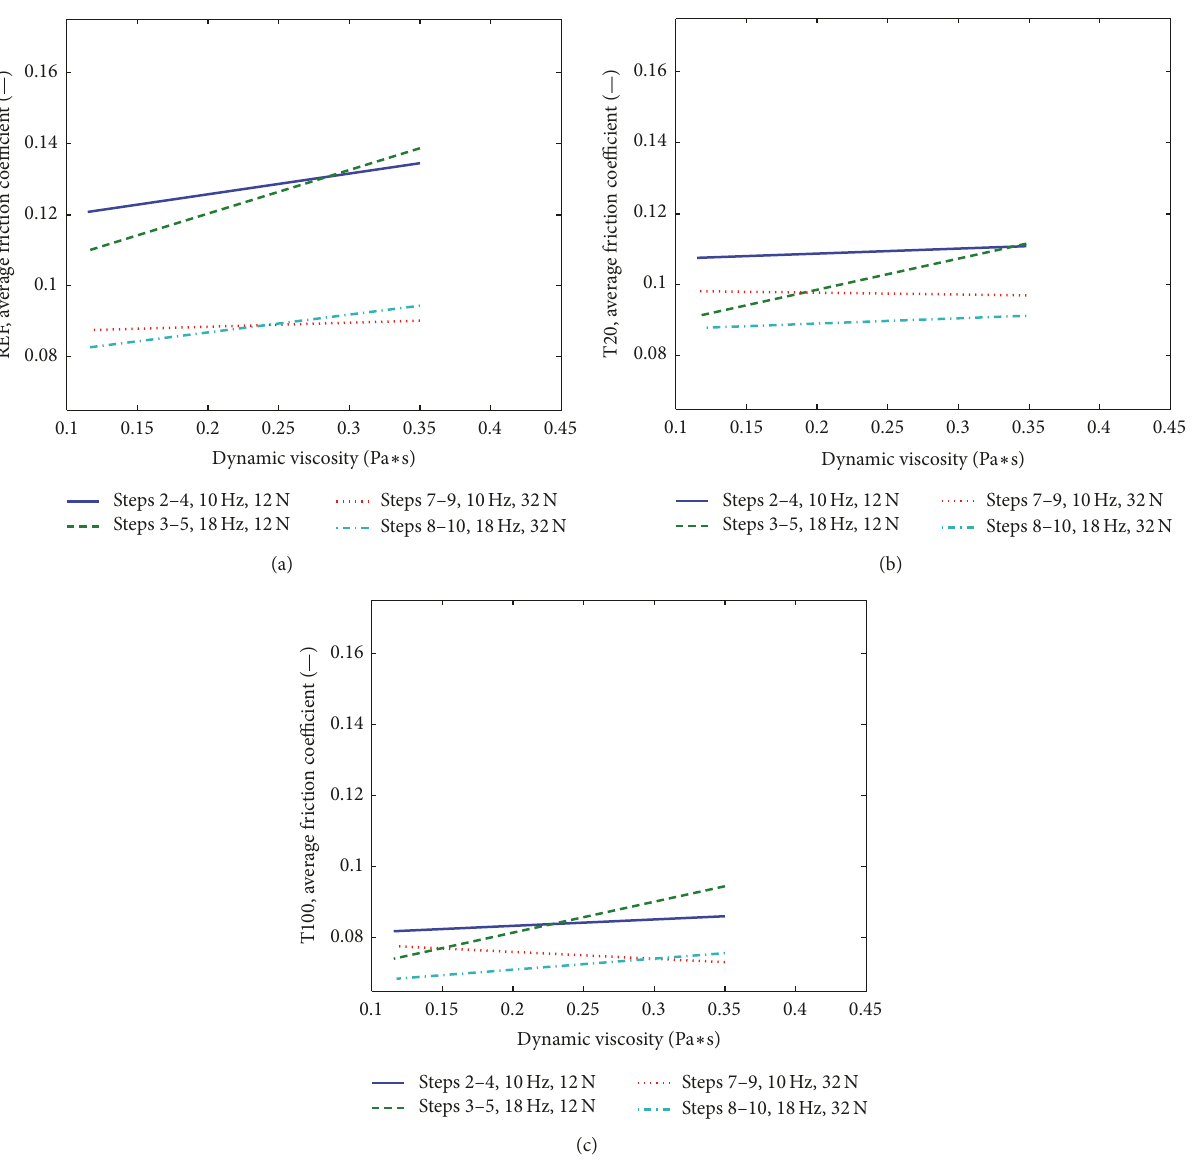
Figure 11: Evaluation of the different levels of DoE input parameters. The effect of dynamic viscosity on the friction coefficient. (a) REF. (b) T20. (c)